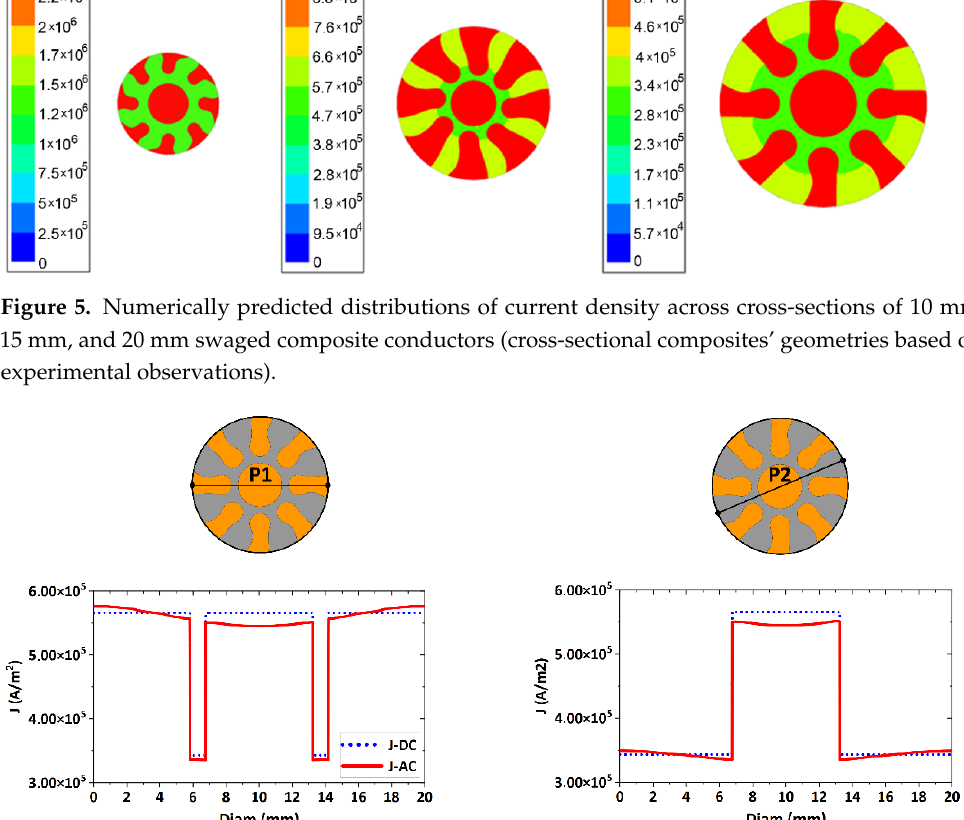
Figure 6. Distributions of current density for 20 mm swaged composite conductor along paths P1 and P2 across the conductor